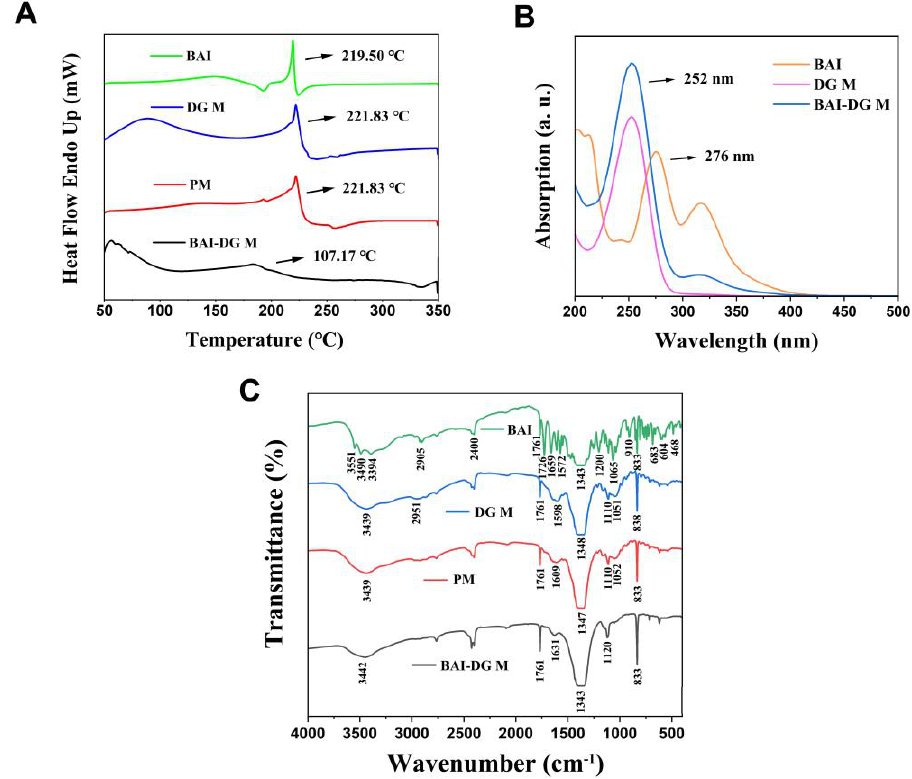
Figure 4. ( A ) DSC thermograms, ( B ) UV absorption spectra and ( C ) FT-IR spectra of BAI, DG Ms, the physical mixture of BAI and DG (PM), and BAI-DG Ms. Since PM can form micelles in solution, UV spectral scanning was not performed on PM (DG represents diammonium glycyrrhizinate, and BAI represents baicalin).